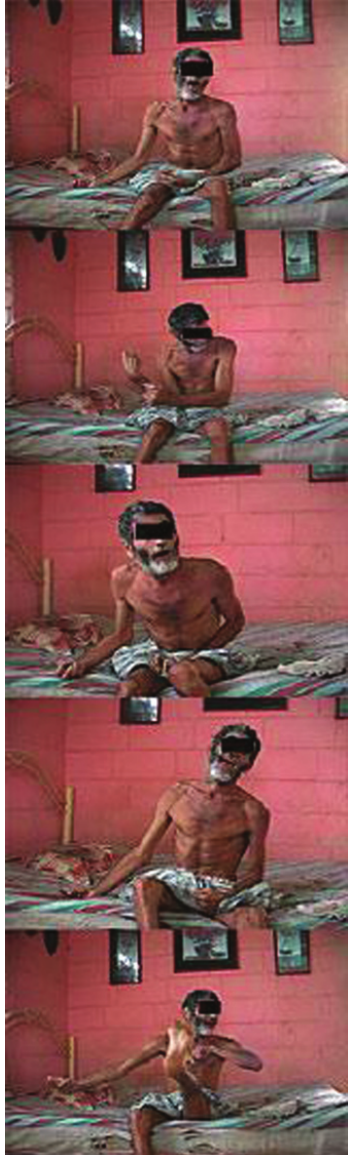
Figure 2 - Sequential head-neck-leg tic, dystonic/chorea movements. Muscle atrophy also noted.